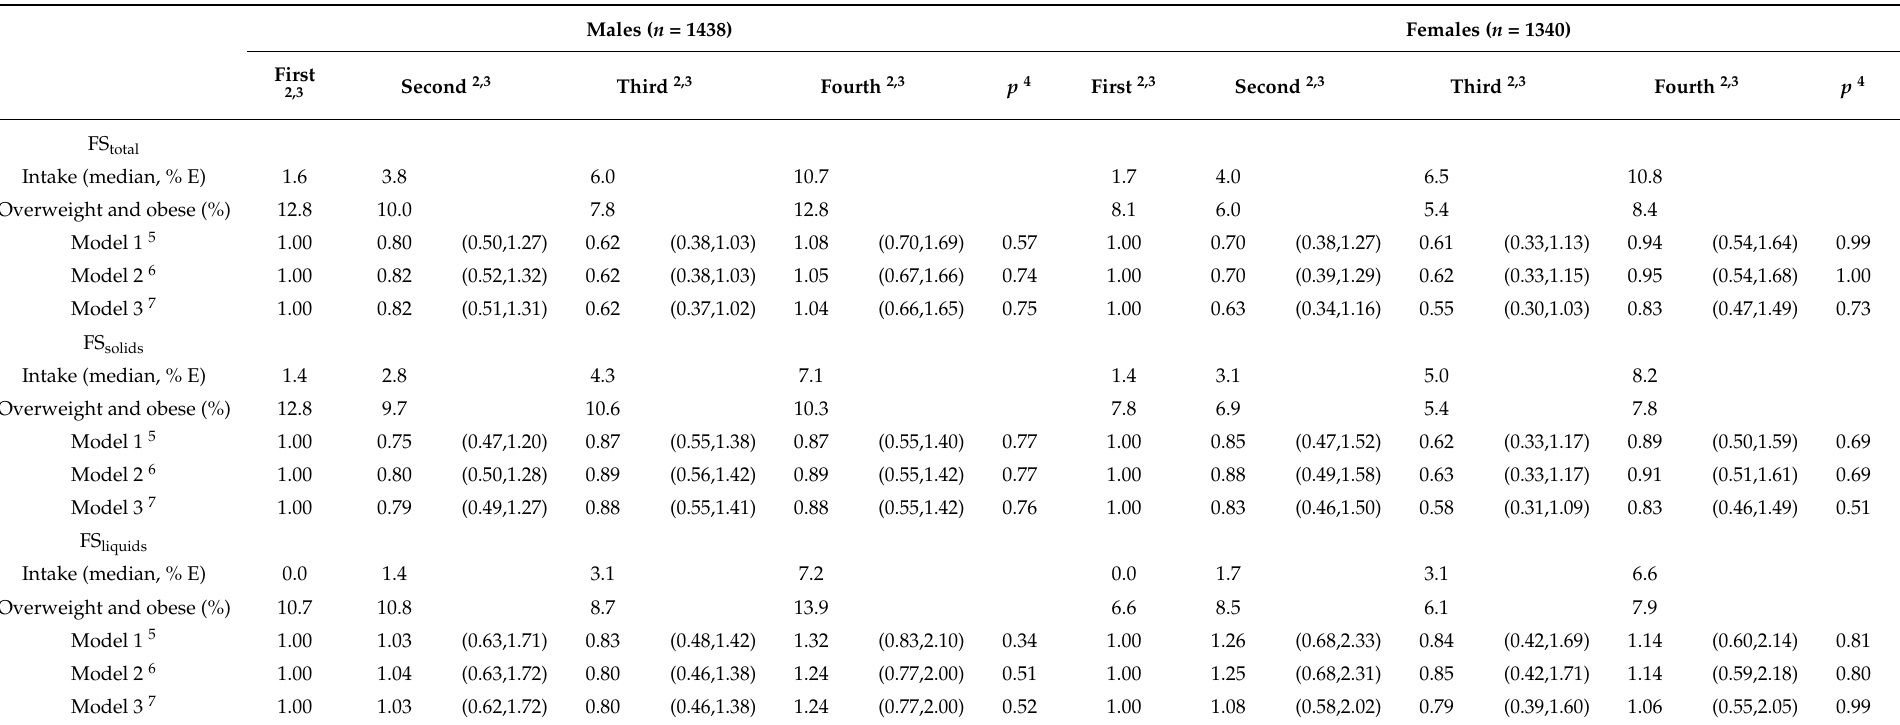
Table 4. ORs (95% CIs) for overweight and obese Japanese children and adolescents aged 2–19 years according to free sugars intake: the 2016 National Health and Nutrition Survey, Japan 1